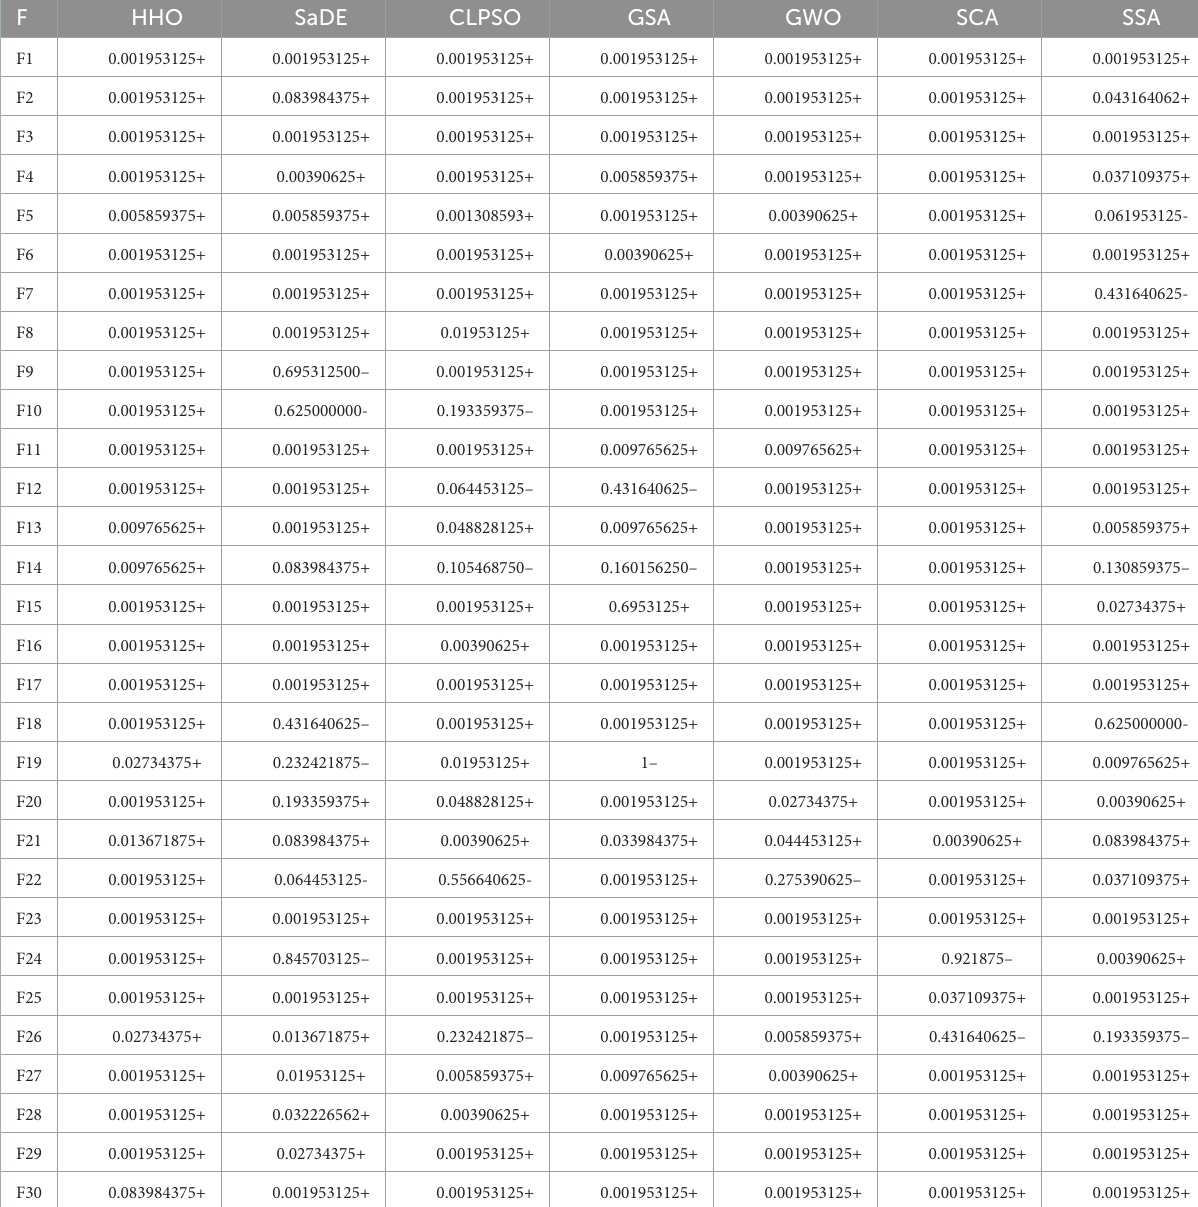
TABLE 2 The calculated p-values for FWHHO vs. state-of-the-art